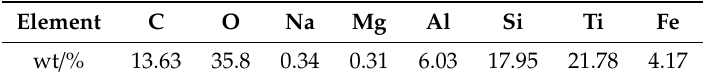
Table 1. Energy dispersive X-ray spectroscopy (EDS) analysis results for the composition of natural pollutions on the surface of the